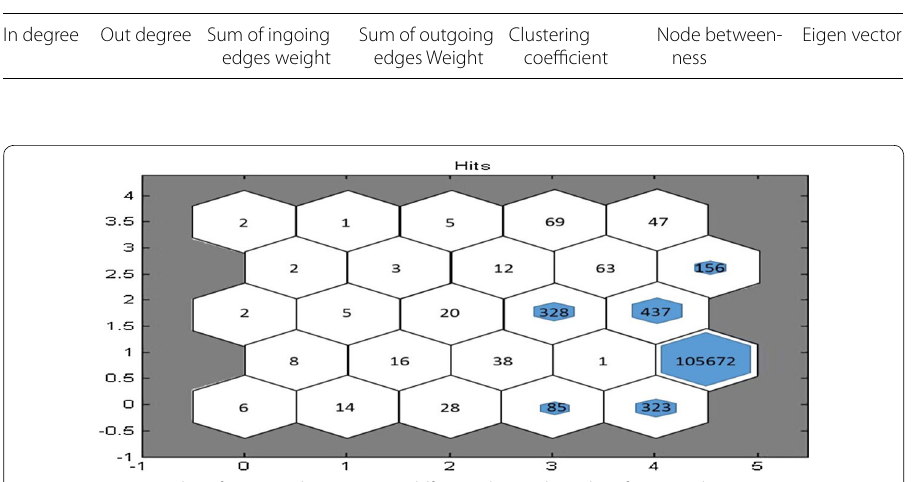
Fig. 6 Mapping nodes of CTU-13/dataset-6 into different clusters based on feature